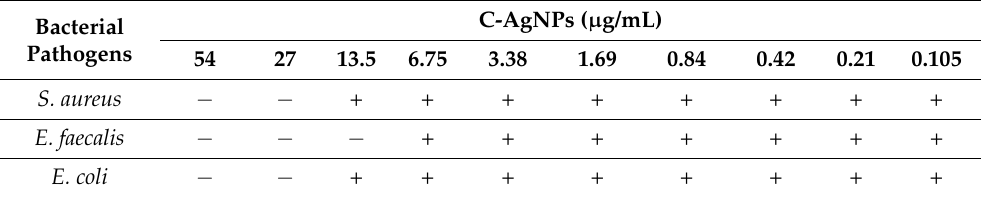
Figure 8. ( a ) Measurements of the zone of inhibition diameters at 108, 216, and 432 µg/mL concentrations of C-AgNPs against the MRSA , S. aureus , E. faecalis , E. coli , S. typhimurium , K. pneumoniae , and P. aeruginosa , and ( b ) bar graph representation. Table 2. MIC values were obtained for